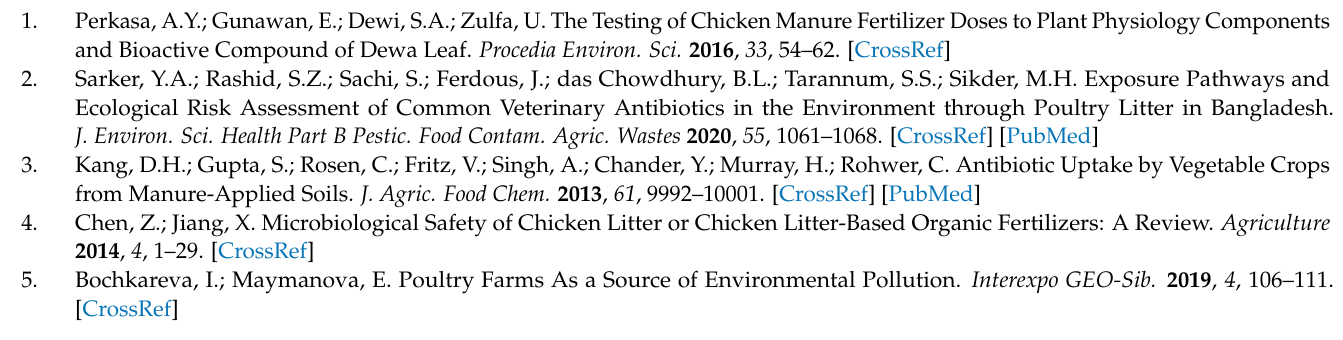
Table S1: Variable parameters in tested SLE procedures. Table S2: Variable parameters in tested SLE-SPE procedures. Table S3: The application of different solvents to SLE procedure for parsley leaf samples. Table S4: The analytical method parameters and extraction recovery of antibiotics in parsley root samples at three different concentrations ( n = 6). Table S5: The analytical method parameters and extraction recovery of antibiotics in parsley leaf samples at three different concentrations ( n =